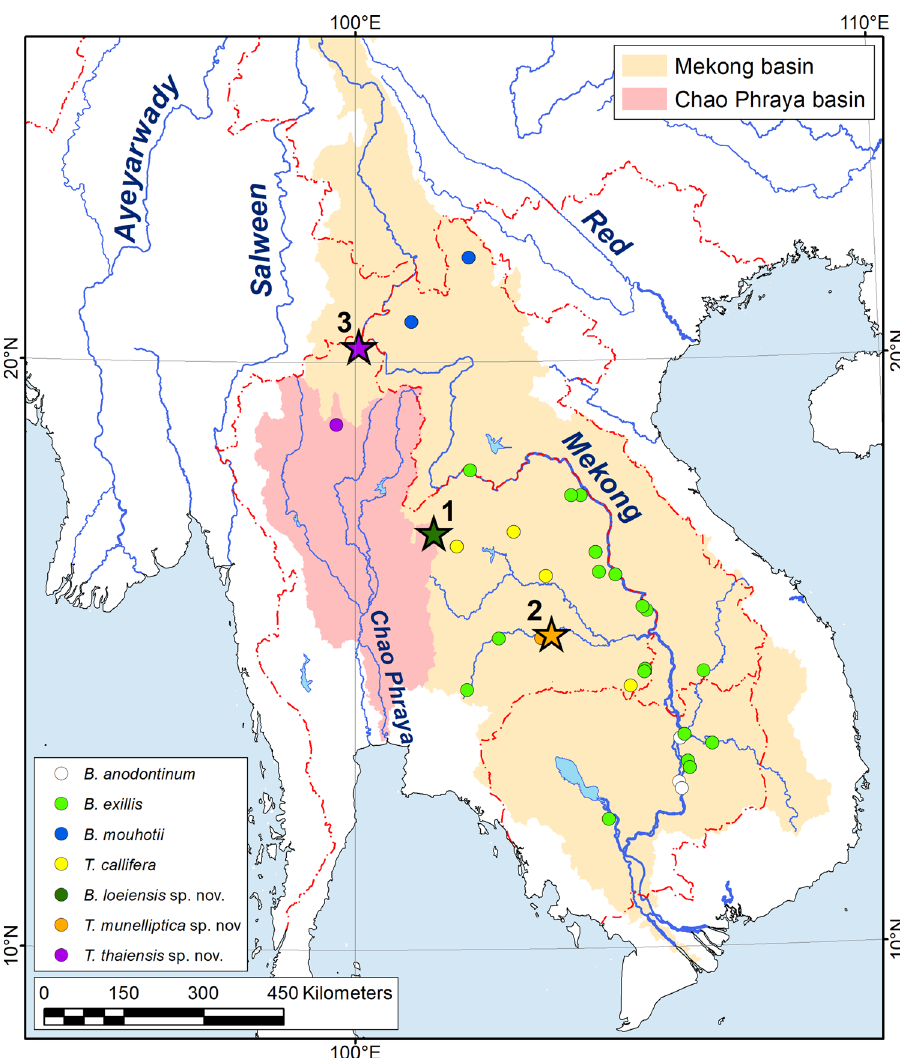
Figure 4. Distribution ranges of Bineurus and Thaiconcha from Mekong and Chao Phraya basins. The type localities of new species are marked by stars: 1— Bineurus loeiensis sp. nov., Loei River, Thailand; 2— Thaiconcha munelliptica sp. nov., Mun River, Thailand; 3— Thaiconcha thaiensis sp. nov., Kham Nong Bua River, Thailand. The corresponding river basins are highlighted in color. The map was developed using ESRI ArcGIS 10 software (www. esri. com/ arcgis). The topographic base of the map was compiled with Natural Earth Free Vector and Raster Map Data (www. natur alear thdata. com), GSHHG version 2.3.7 (http:// www. soest. hawaii. edu/ pwess el/ gshhg) 18 , and the HydroSHEDS database (http:// www. hydro sheds. org) 19, 20 . (Map: Mikhail Yu.